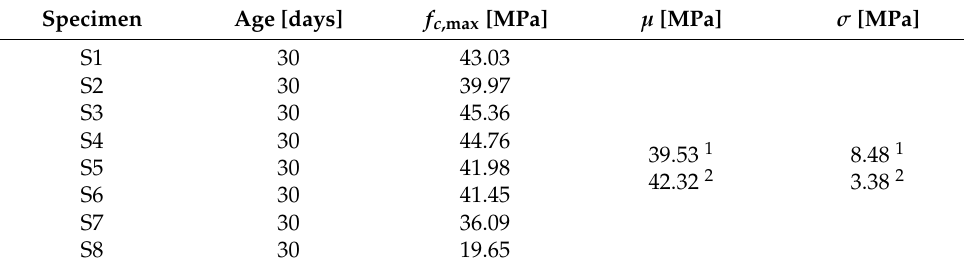
Table 3. Summary of the results from testing of the concrete